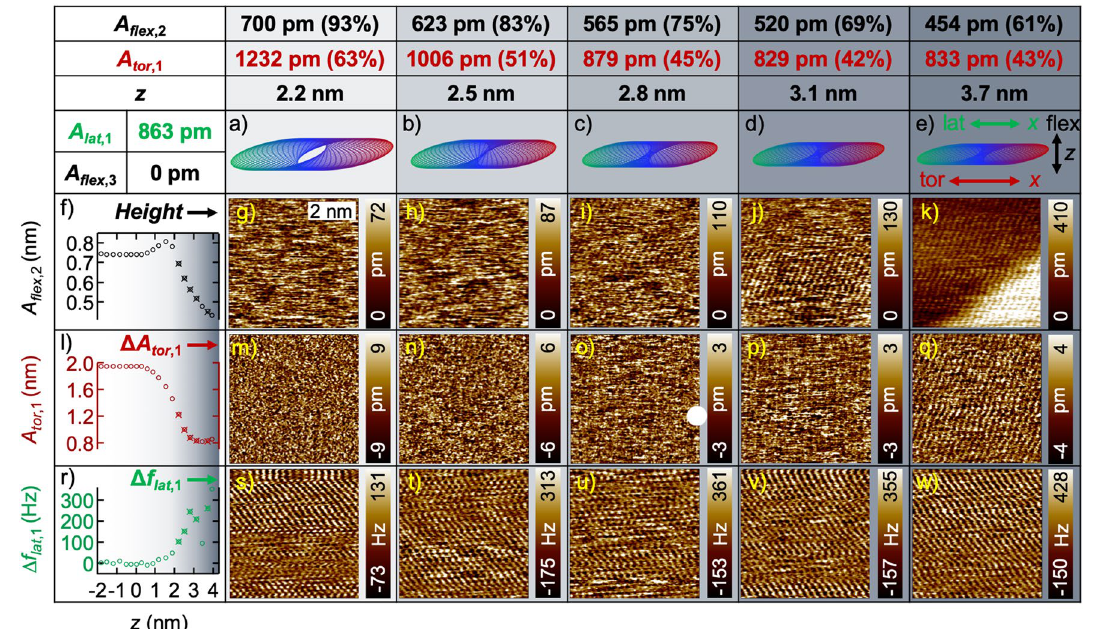
Figure 2. Imaging and spectroscopy on HOPG at a covered step edge in AMFlex2-OLTor1-FMLat1 mode with 863 pm lateral-eigenmode-amplitude setpoint. ( a – e ) Schemes of the tip trajectory for the coupled second flexural and first torsional cantilever oscillation for decreasing second flexural-eigenmode-amplitude setpoints A flex ,2 . The setpoints of A flex ,2 are listed in the first, the corresponding setpoints of the first-torsional-eigenmode amplitude A tor ,1 in the second row and the approximate z -sensor position at the third row. The values in brackets represent the percentages of the setpoints from the free amplitudes A 0 (flex ,2 ) and A 0 (tor ,1 ) . ( f ) Second flexural-, ( l ) first torsional-eigenmode amplitude A tor ,1 and ( r ) first lateral frequency shift Δ f lat ,1 vs. z -sensor position, where the crossed circles mark the positions at which the images where taken. ( g – k ) Height, ( m – q ) first torsional- eigenmode amplitude error Δ A tor ,1 and ( s – w ) Δ f lat ,1 images at decreasing A flex ,2 . Note, that Φ tor, 1 was assumed to be 90° for the calculation of the tip-trajectories shown in ( a – e